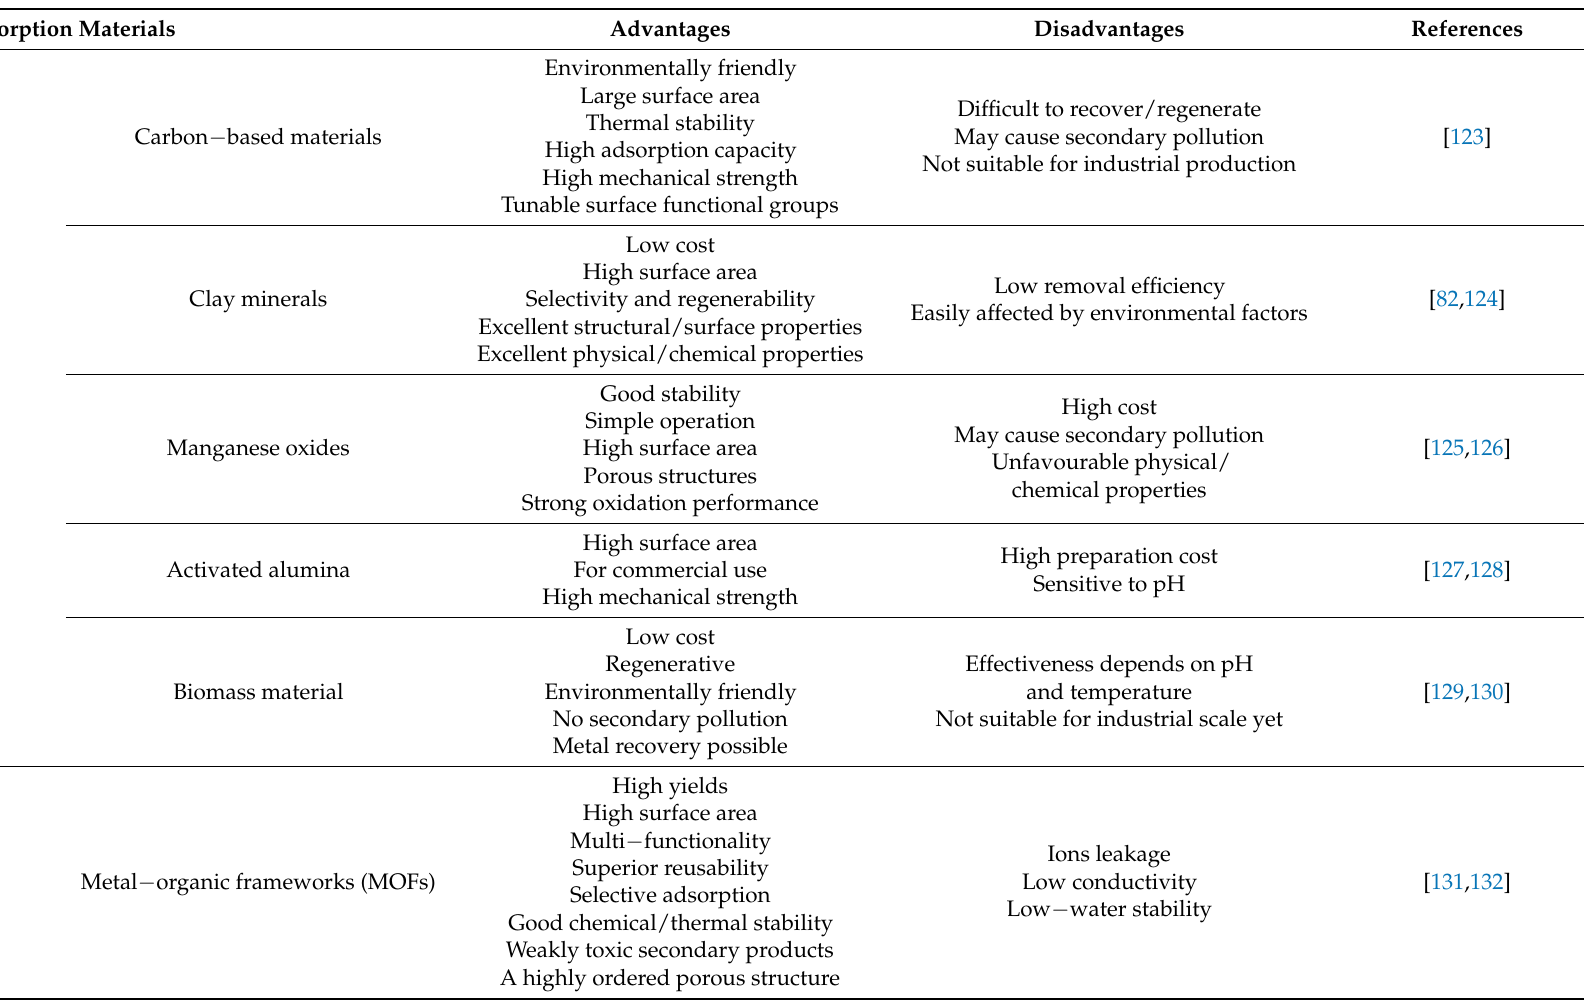
Table 3. Comparison of the advantages and disadvantages of frontier and traditional adsorption